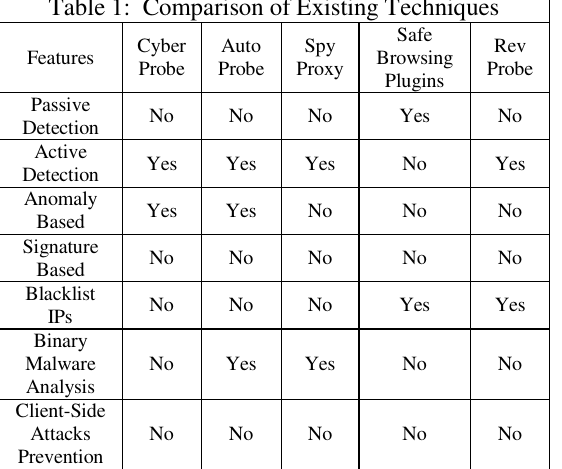
Table 1: Comparison of Existing Techniques